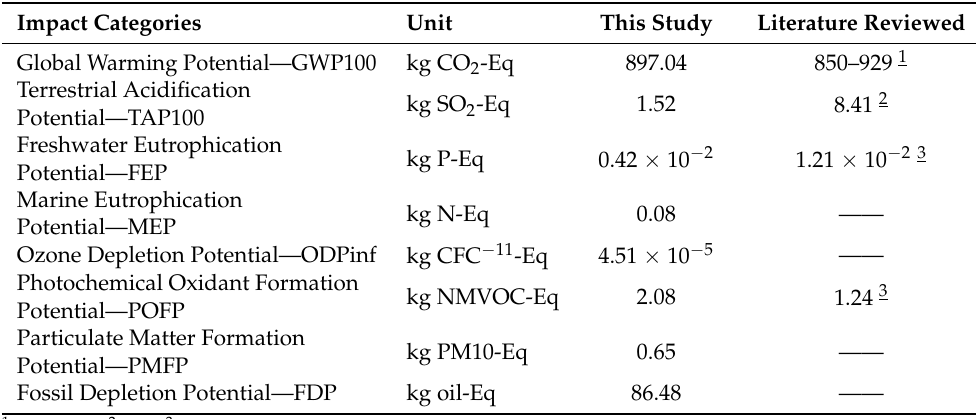
Table 1. Result of life cycle assessment impact categories for 1 ton of